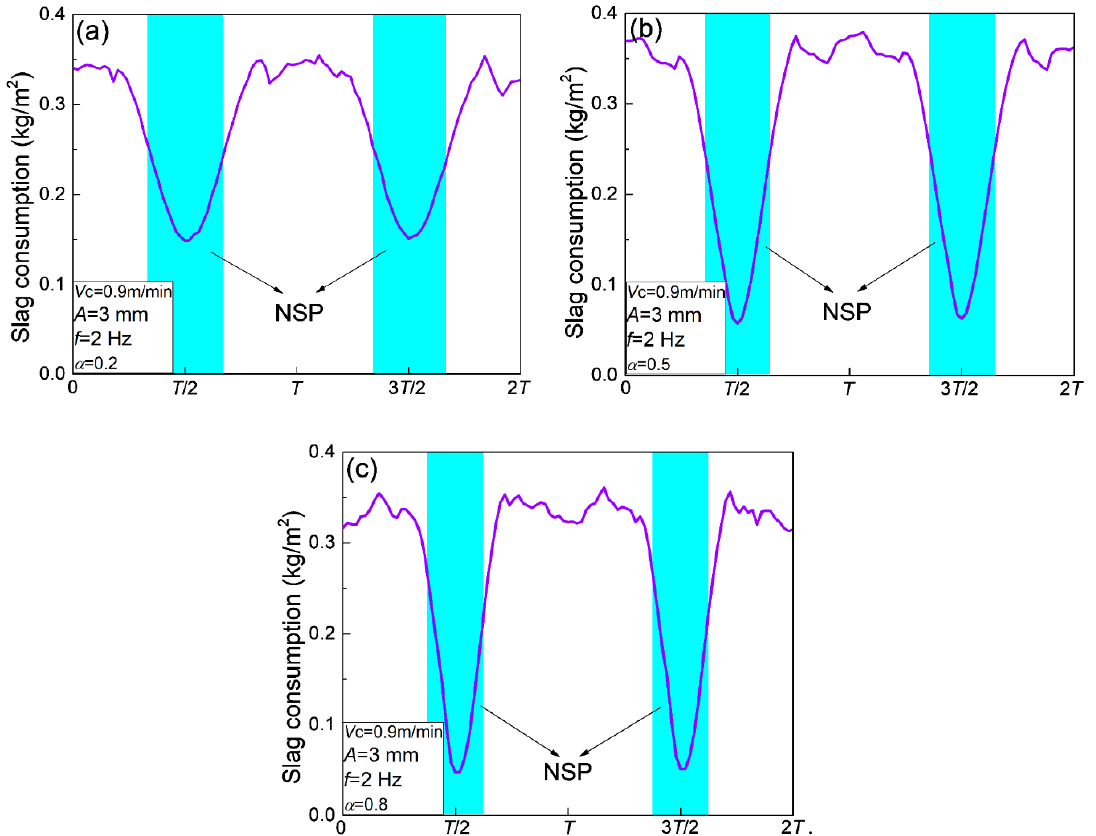
Figure 8. Variations of slag consumption of nonsinusoidal oscillation with different modification ratios: ( a ) α = 0.2, ( b ) α = 0.5, and ( c ) α = 0.8.